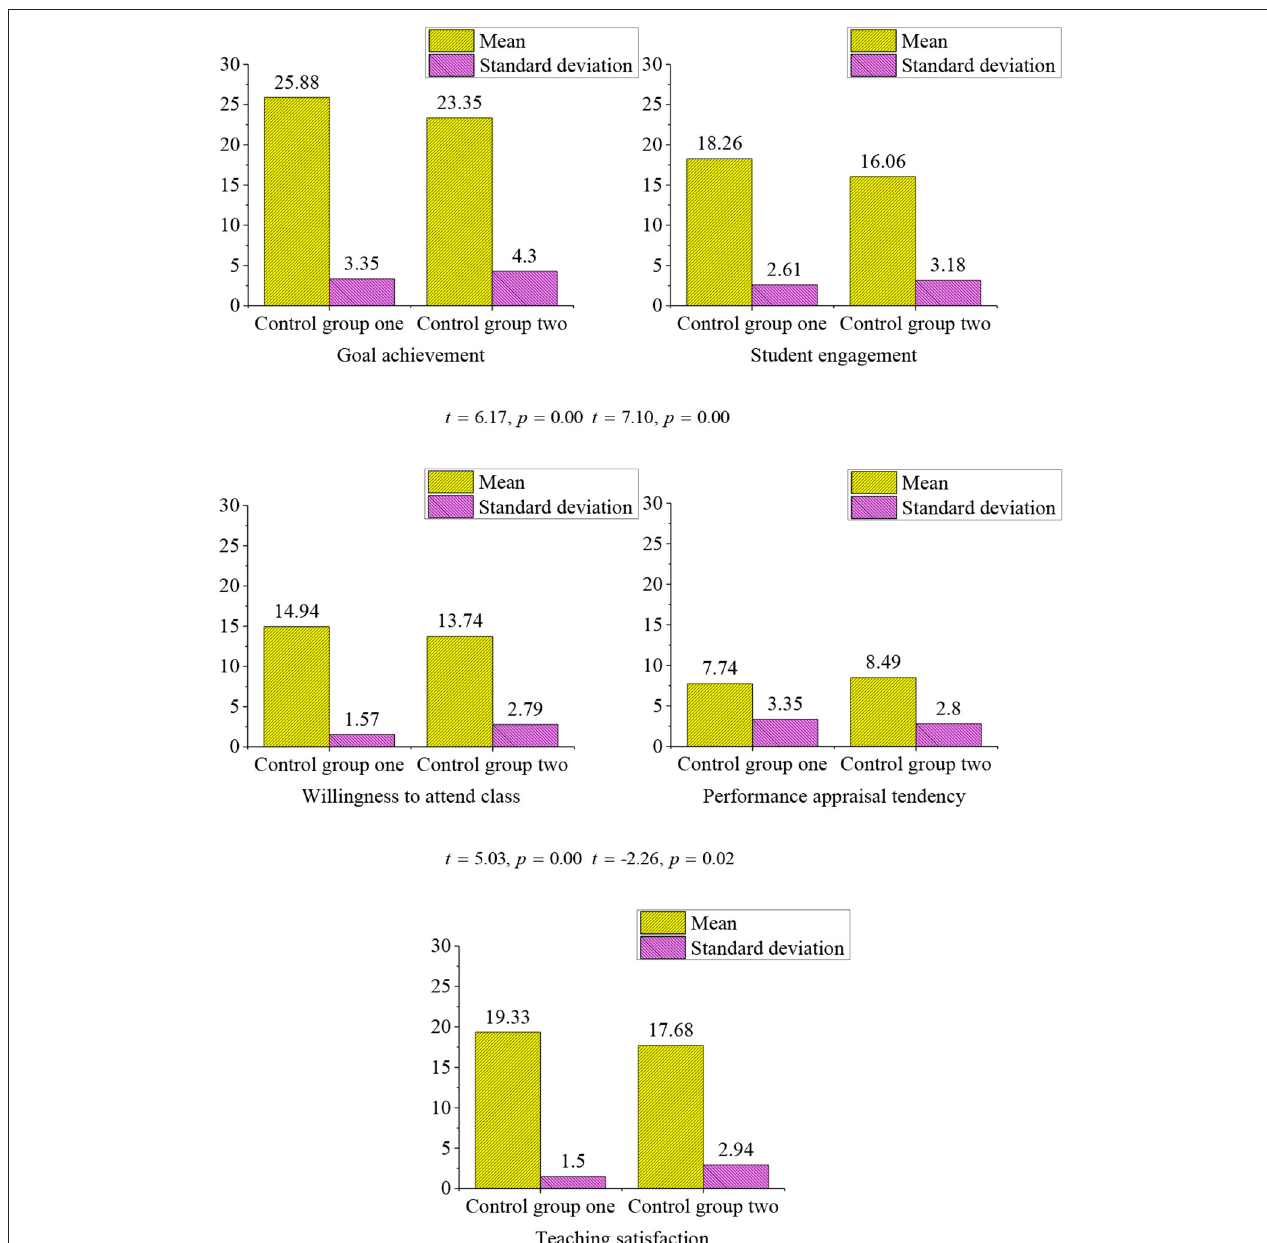
FIGURE 9 | The t -test of the control group 1 and control group 2 (control group 1, n1 = 168, control group 2, n2 =